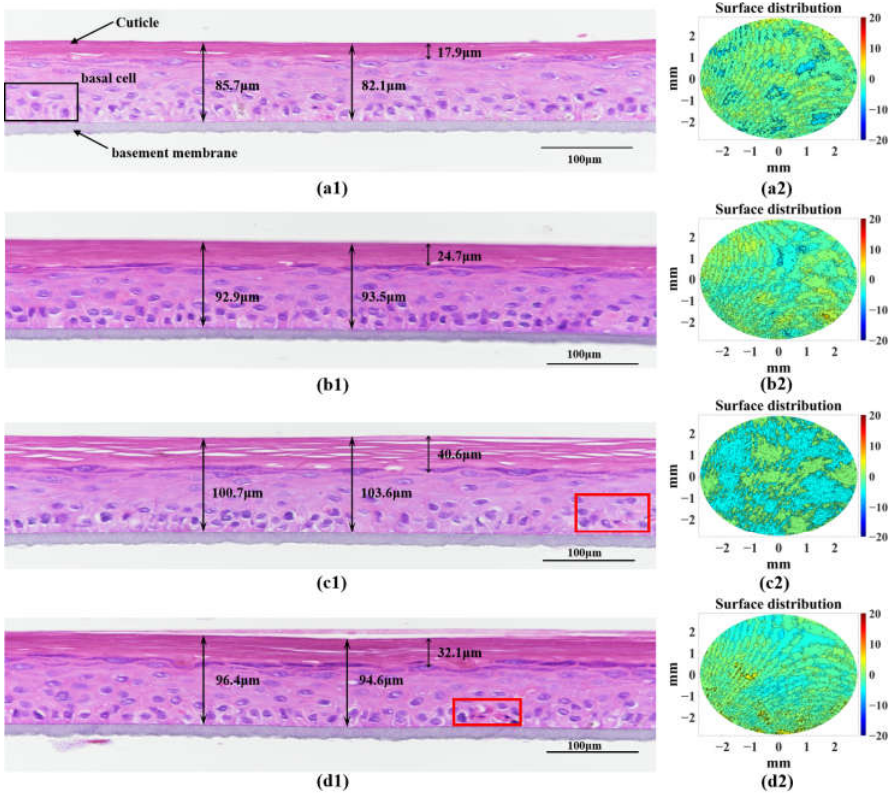
Figure 8. H&E staining microscopic pictures and surface profile maps. ( a1 – d1 ) H&E staining micro- scopic pictures of Before irradiation, NC-Day4, UV-Day4 and UV + VC-Day4; ( a2 – d2 ) Surface profile darkly stained clusters of apoptotic